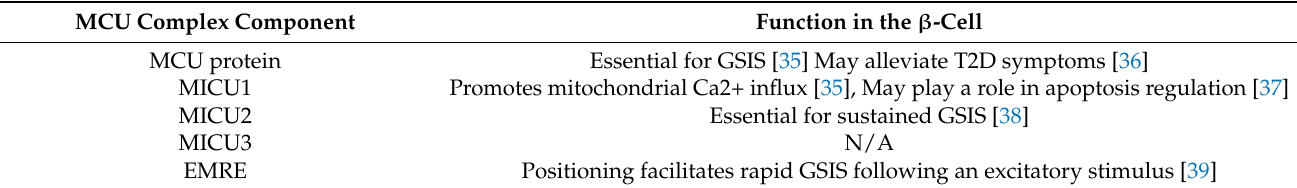
Table 1. Known MCU complex components and their function in the pancreatic β